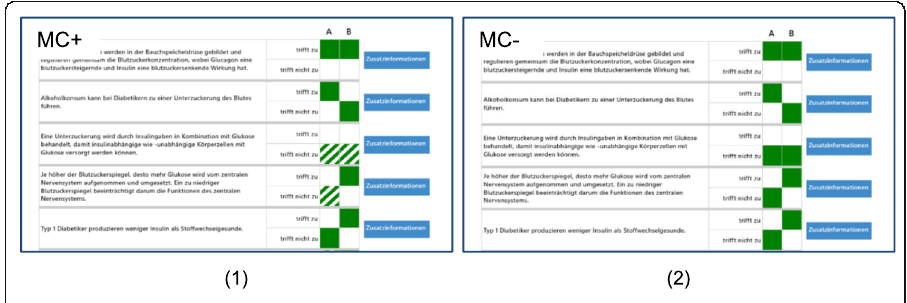
Fig. 2 Arrangement of collaborative learning scenario on the multi-touch tabletop; (1) with metacognitive information available (MC+); (2) without metacognitive information available (MC −